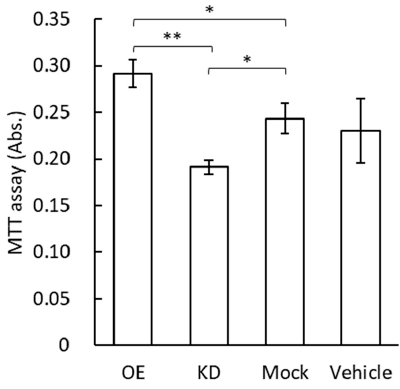
Figure 4. The MTT assay for vascular endothelial cells by the application of exosomes containing various concentrations of GRP78. The y -axis indicates absorbance of 570 nm, showing that the higher the absorbance, the more viable the cells; n = 4 each; * and ** indicate p < 0.05 and p < 0.01, respectively.